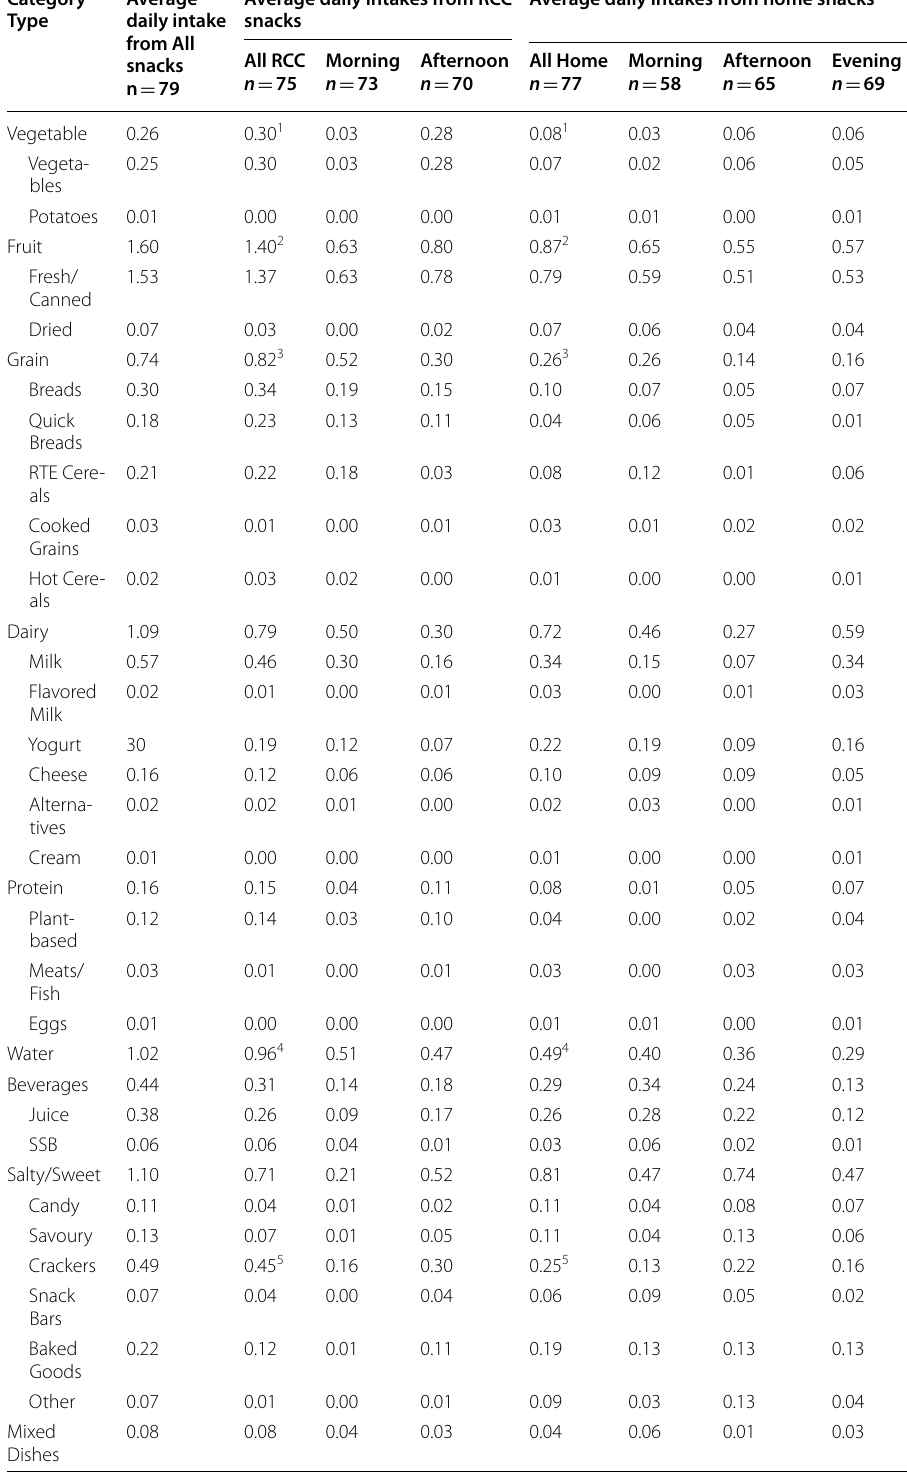
Table 2 Average daily intakes of food category/type from all, regulated child care (RCC) and home snacks Category